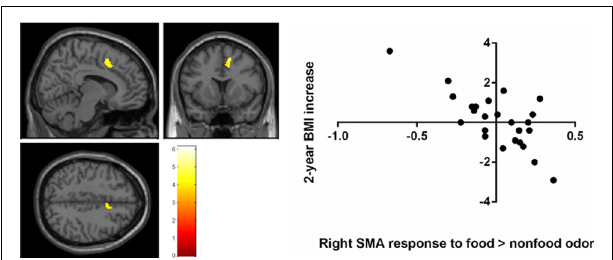
FIGURE 3 | Negative correlation between the 2-year BMI increase and the baseline brain responses to food vs. nonfood odors in the right supplementary motor area (SMA) Brain activation were significant with corrected p < 0.05 and were illustrated on a template provided in SPM12